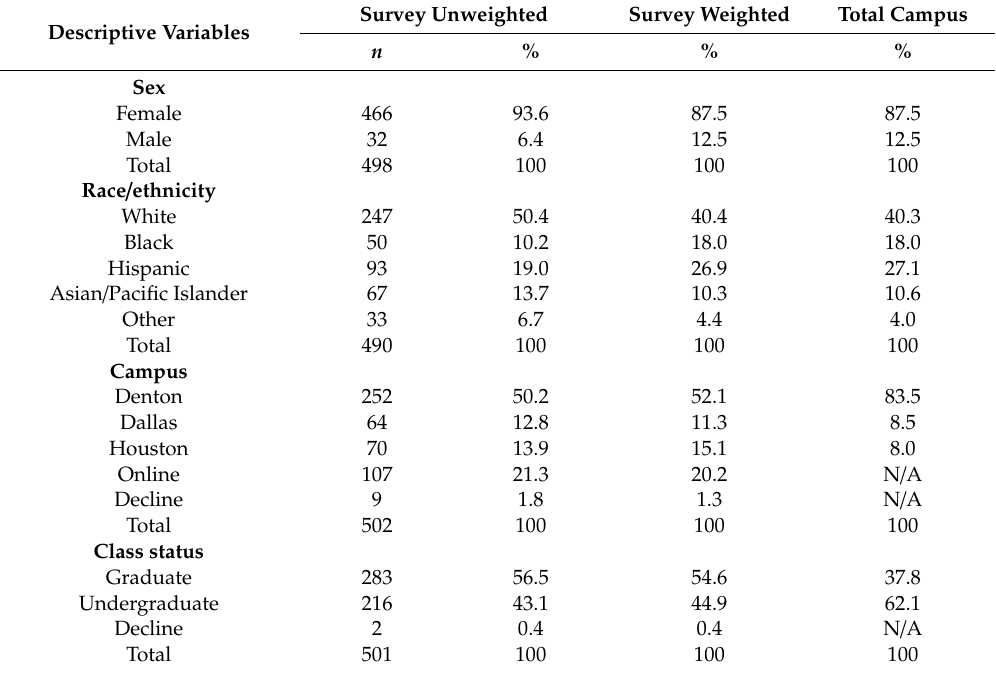
Table 2. Sociodemographic and other characteristics of survey respondents ( n =